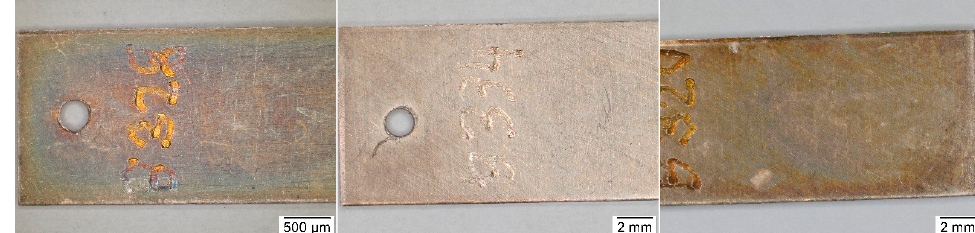
Figure 2. Comparison of the appearance of silver coupons after exposure in an archive ( left ) and in a wooden box with an acetate film ( right ).